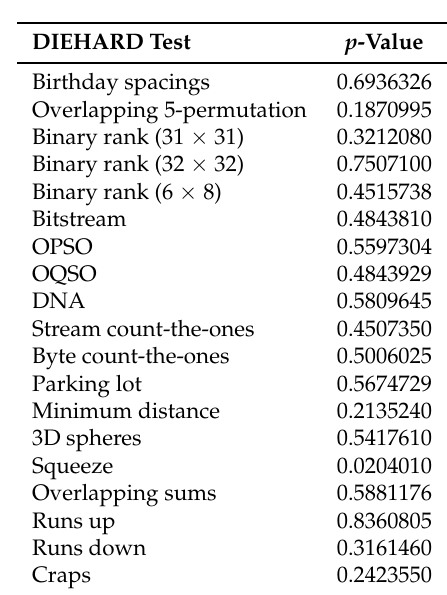
Table 2. DIEHARD statistical test results.